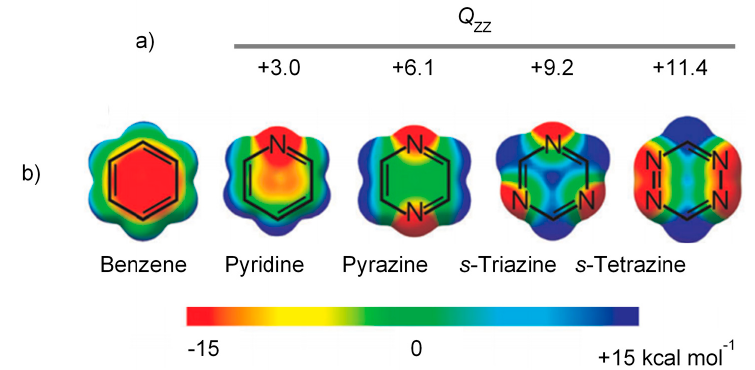
Figure 2. (a ) Q zz quadrupole moments (in Buckinghams) for azines, relative to benzene. ( b ) Total ESPs of benzene and azines, mapped onto the corresponding electron density isosurfaces. Partially reproduced from ref. [35] with permission from the Royal Society of Chemistry.